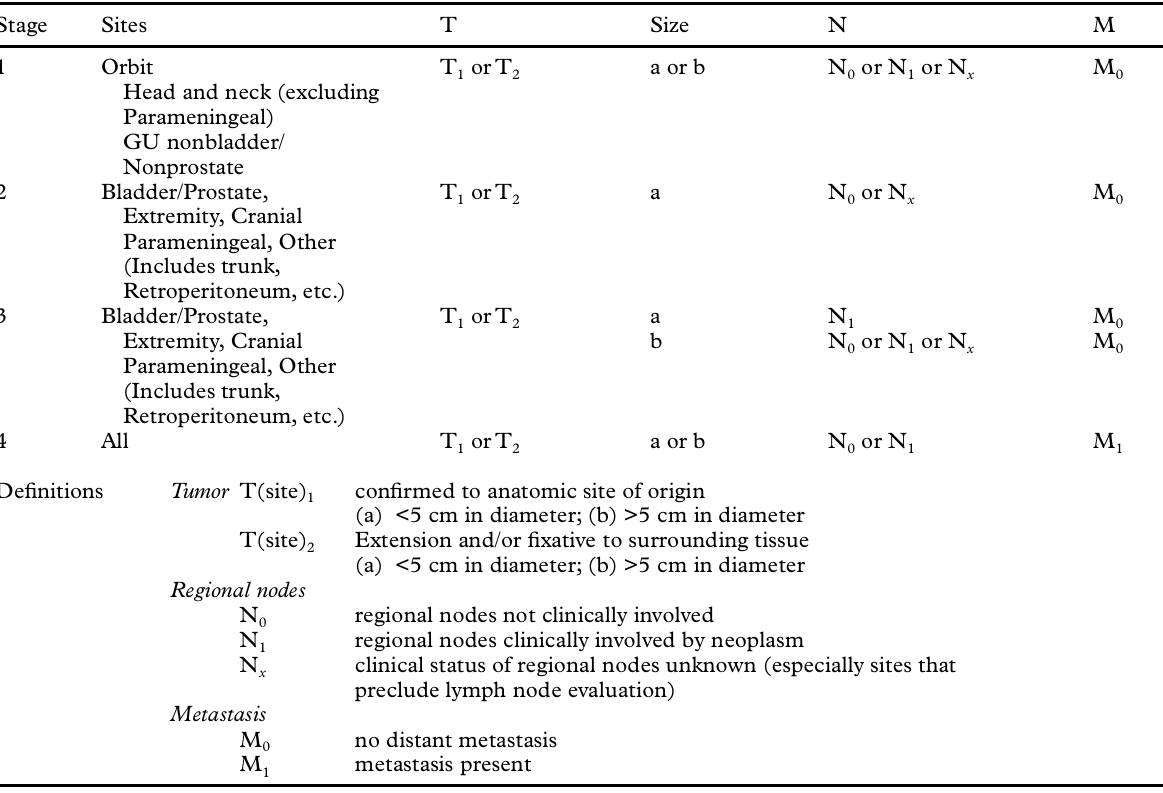
Table 1. TNM pretreatment staging classi(cid:142) cation. Staging before treatment requires thorough clinical, laboratory, and imaging examinations. Biopsy is required to establish histological diagnosis. Pretreatment tumor size is determined by external measurement or MRI or CT,depending on anatomic location.For less accessible primary sites,CT also will be used for lymph node assessment.Metastatic sites will require some form of imaging (but not histological con(cid:142) rmation, except for bone marrow examination) con(cid:142) rmation.